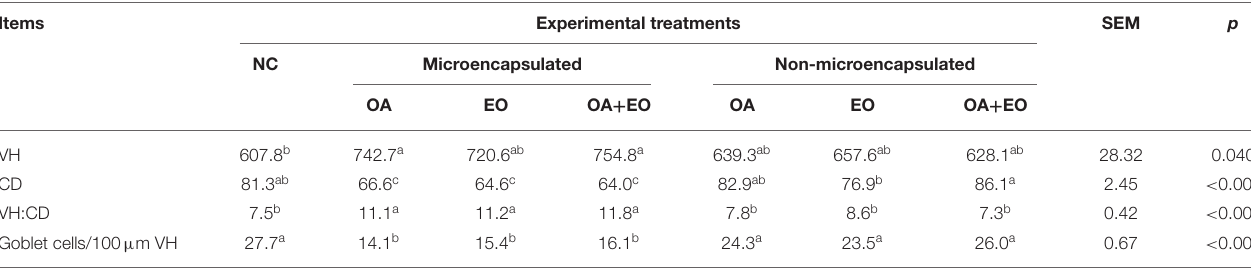
TABLE 3 | Effect of dietary treatments on the ileal histomorphology on day 35 of age.